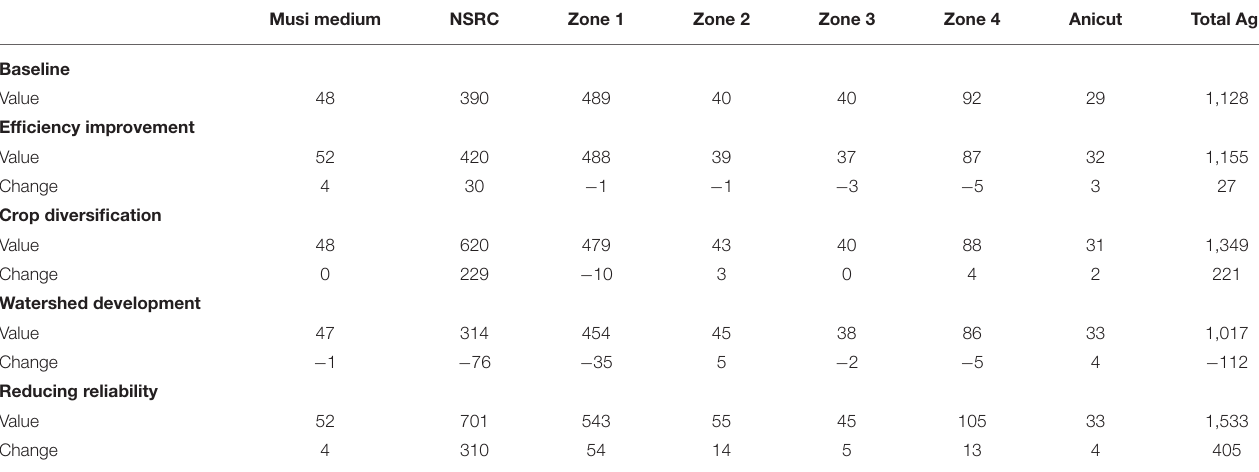
TABLE 3 | The value of bulk irrigation supplies distributed in the Musi catchment and the changes within regions from introduced measures at the 80% level of reliability ($US